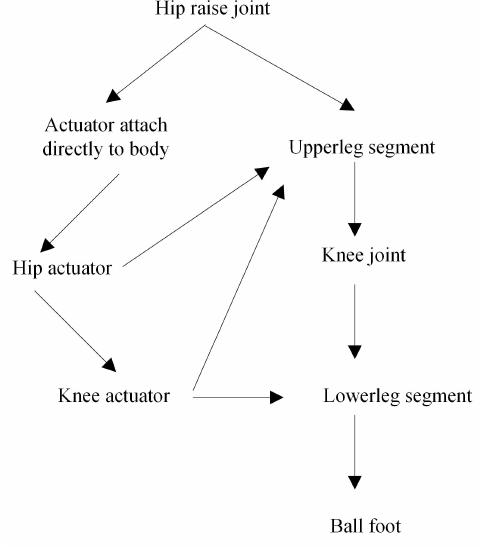
Fig. 5 “Humanoid Robotics”ontology O